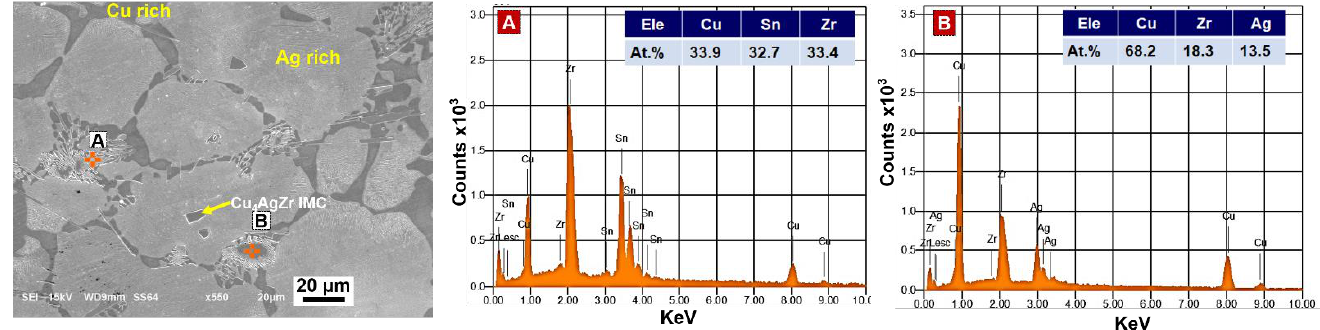
Figure 2. Microstructure of as-cast Ag-18Cu-6Sn-3Zr filler with EDS analysis of spots A and B. Ag-Cu system is an interesting combination having the same crystal structure (face- centered cubic) and positive enthalpy of mixing (10.8 KJ·mol −1 [23]). During solidification, to attain equilibrium Cu and Ag atoms tend to segregate and forms Cu-rich and Ag-rich